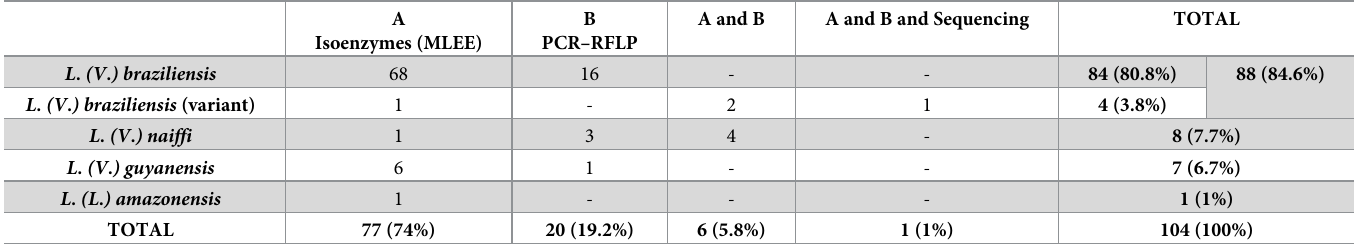
shawi profile after digestion with Bst UI enzyme. To confirm the species, genetic sequencing of the ITS1-rDNA was performed and the consensus sequence is shown as supplementary data– S1 Consensus_Sequence. Phylogenetic analyses (Fig 1) and genetic distance percentage between the P4 isolate and other Leishmania species (Table 4) confirmed the P4 isolate to be a genetic variant of L . (V . ) braziliensis . Of the 104 Leishmania species identified, 101 were from Brazil and 3 from other countries. In the South, Southeast and Midwest Regions 100% of the species identified were L . (V . ) brazi- liensis . All the four L . (V . ) braziliensis (variants) identified were from the North Region. In the North region, of the 26 Leishmania species identified, 11 (42.3%) were different from L . (V . ) braziliensis and in the Northeast region, of the 26 Leishmania species identified, 3 (11.5%) were different of L . (V . ) braziliensis (p = 0,012) (Tables 5 and Supplementary data–S2 Table). The predominant clinical form was CL (n = 80; 77%), followed by ML (n = 17, 16.3%) and MCL (n = 7; 6.7%) (Supplementary data–S2 Table). Table 3. Identification techniques used for typing of 104 Leishmania species isolated from travelers and migrants who were patients attended at NIID-FIOCRUZ from 2000 to